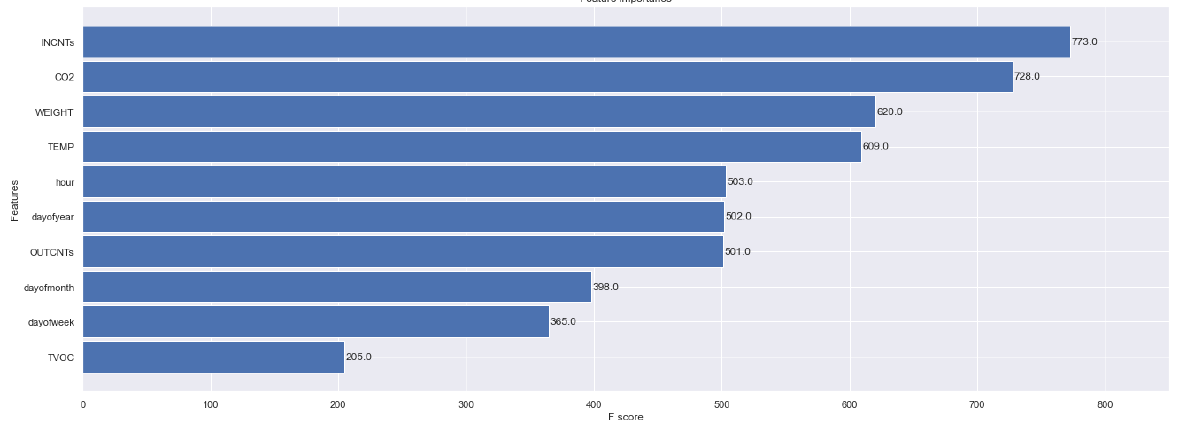
Table 3. Error metrics for the humidity variable.